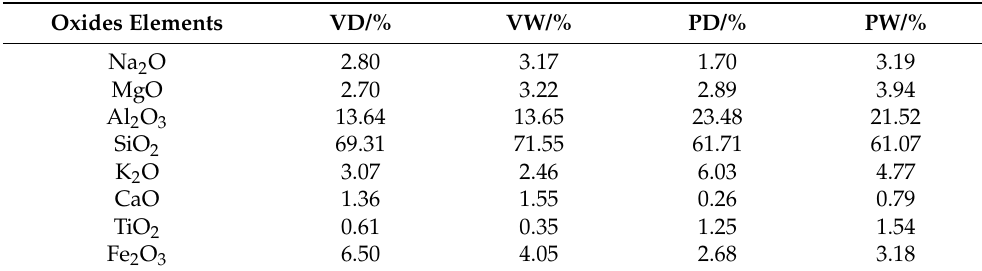
Table 3. Different quantification mineral composition.